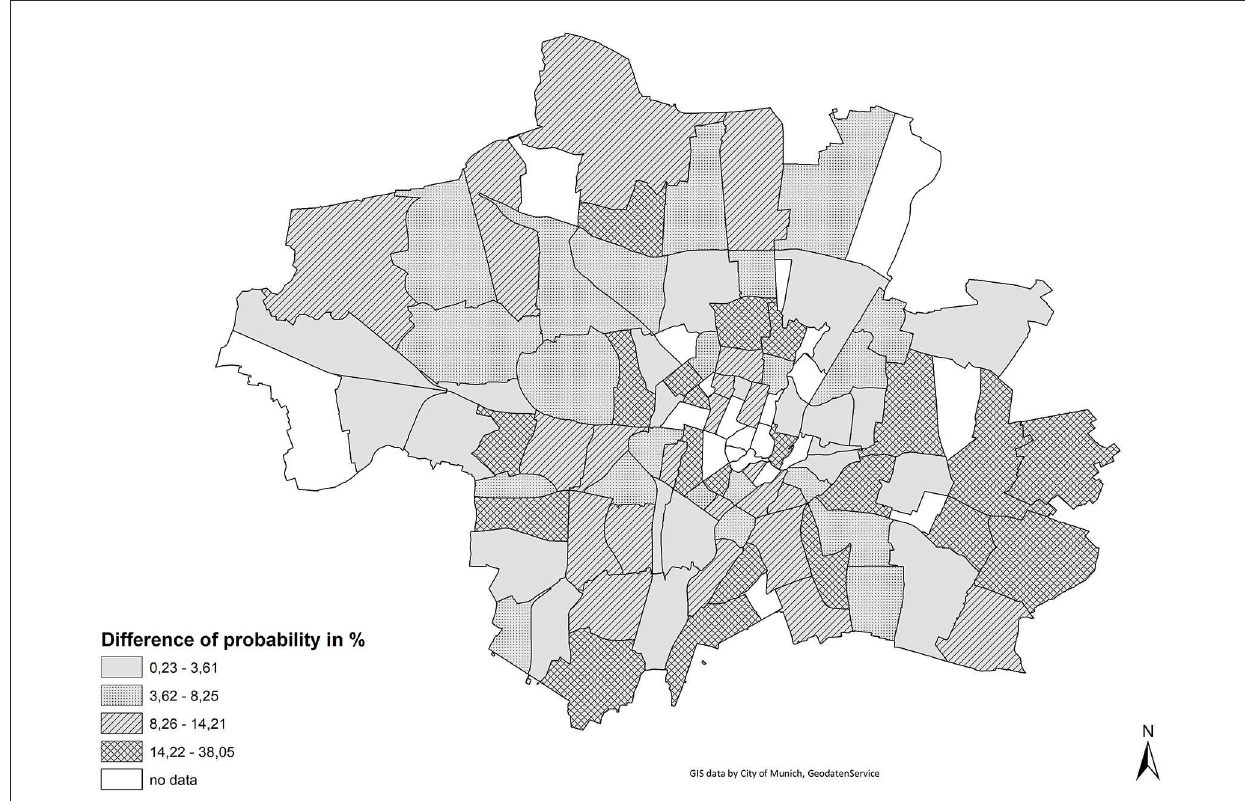
FIGURE5 Probabilities of living in a district for a person with immigrant background when controlling for socio-economic